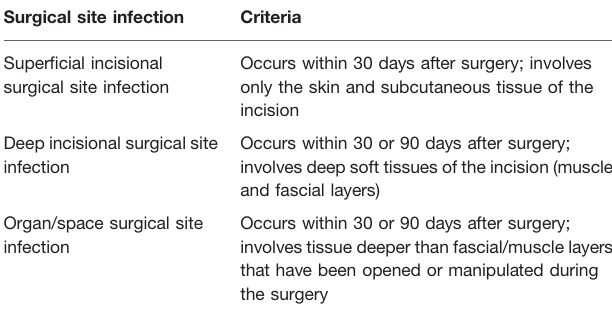
TABLE 1 | Classi fi cation of surgical site infection according to the CDC (Center of Disease Control) (11, 12). Surgical site